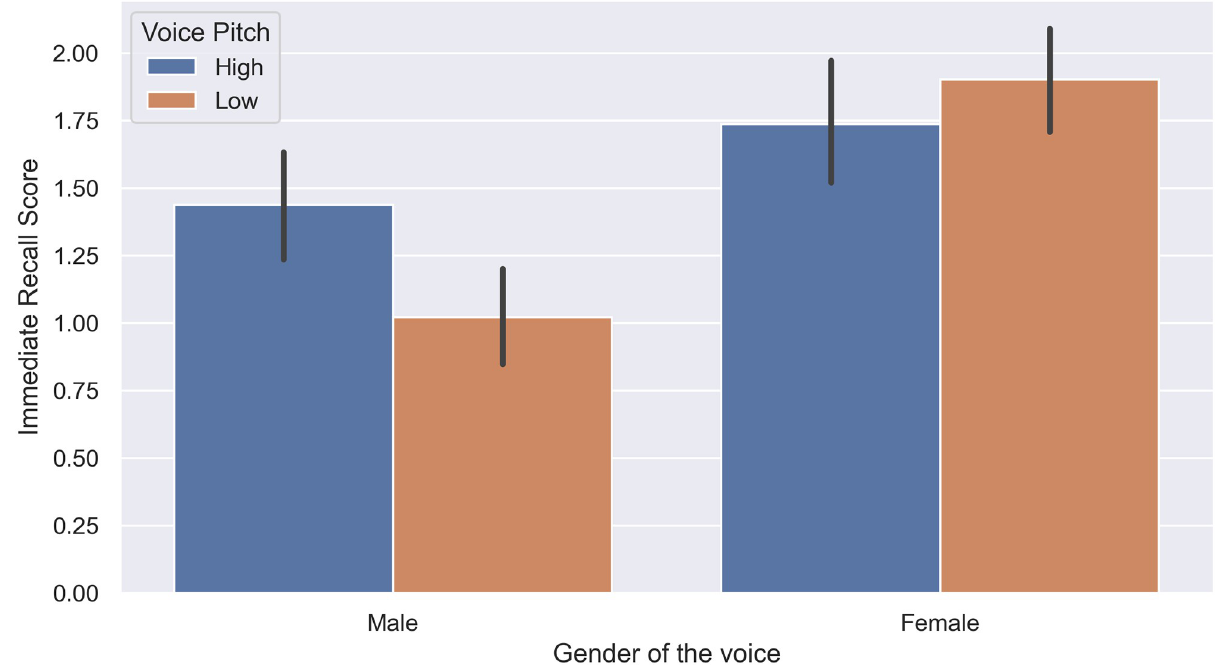
Fig 2. Interaction of voice gender and voice pitch in the immediate recall task (Experiment 1).